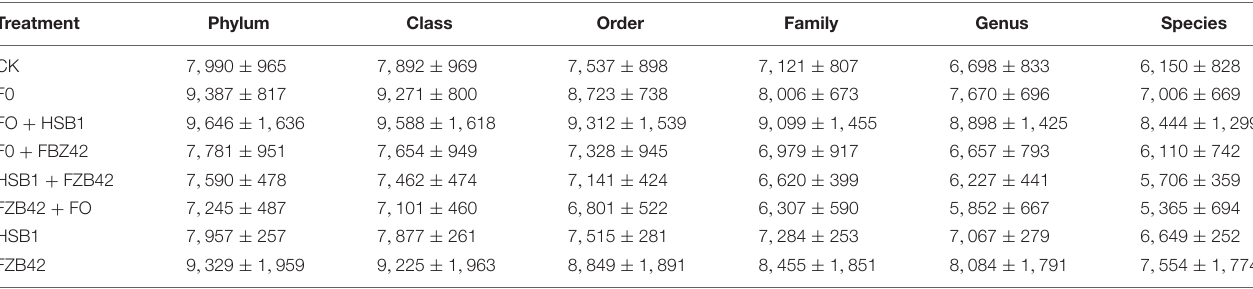
FIGURE 5 | Bar charts showing disease incidence (A–C) , blue bars) and disease severity (D–F) , orange bars) for all treatments recorded at 15, 21, and 25 days time points. Error bars represent standard error of three replicateds. Letters above each bar indicate significant differences in disease incidence at 25 days between F. oxysporum , HSB1 + F. oxysporum , and F. oxysporum + FZB42, and treatments ( p < 0.05). TABLE 2 | OTU classification and corresponding numbers in with various